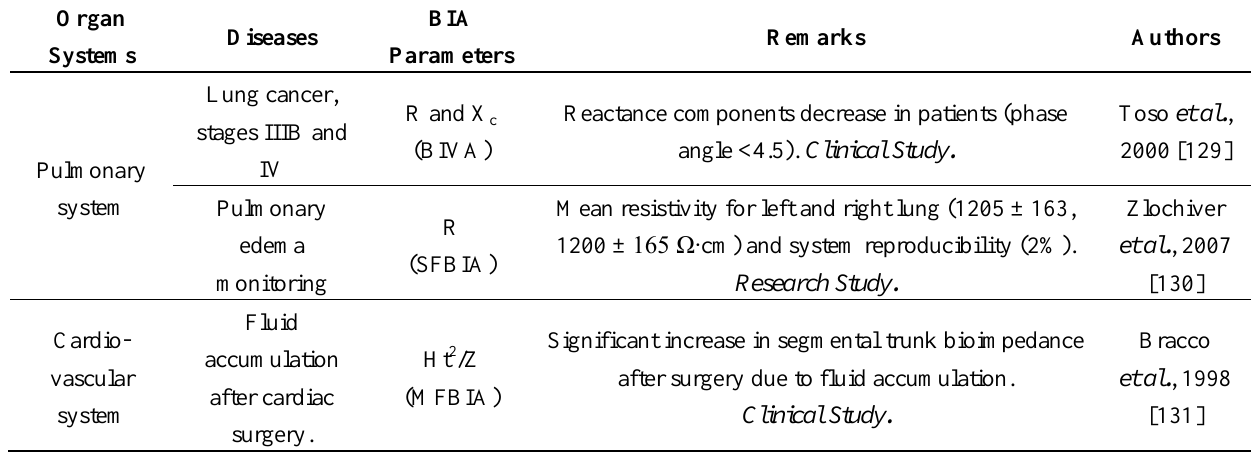
Table 1. Applications of bioimpedance analysis in clinical status monitoring and diagnosis of